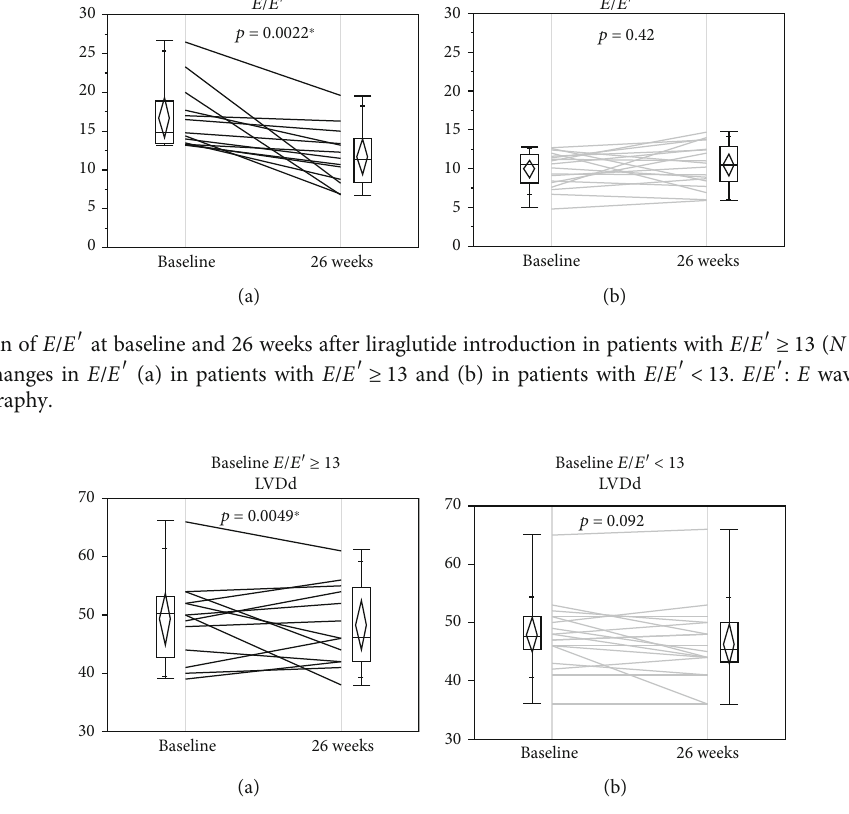
Figure 3: Comparison of LVDd at baseline and 26 weeks after liraglutide introduction in patients with E / E ′ ≥ 13 ( N = 13 ) and those with E / E ′ < 13 ( N = 18 ). Changes in LVDd (a) in patients with E / E ′ ≥ 13 and (b) in patients with E / E ′ < 13 . E / E ′ : E wave to E ′ ratio on tissue Doppler echocardiography; LVDd: left ventricular diastolic